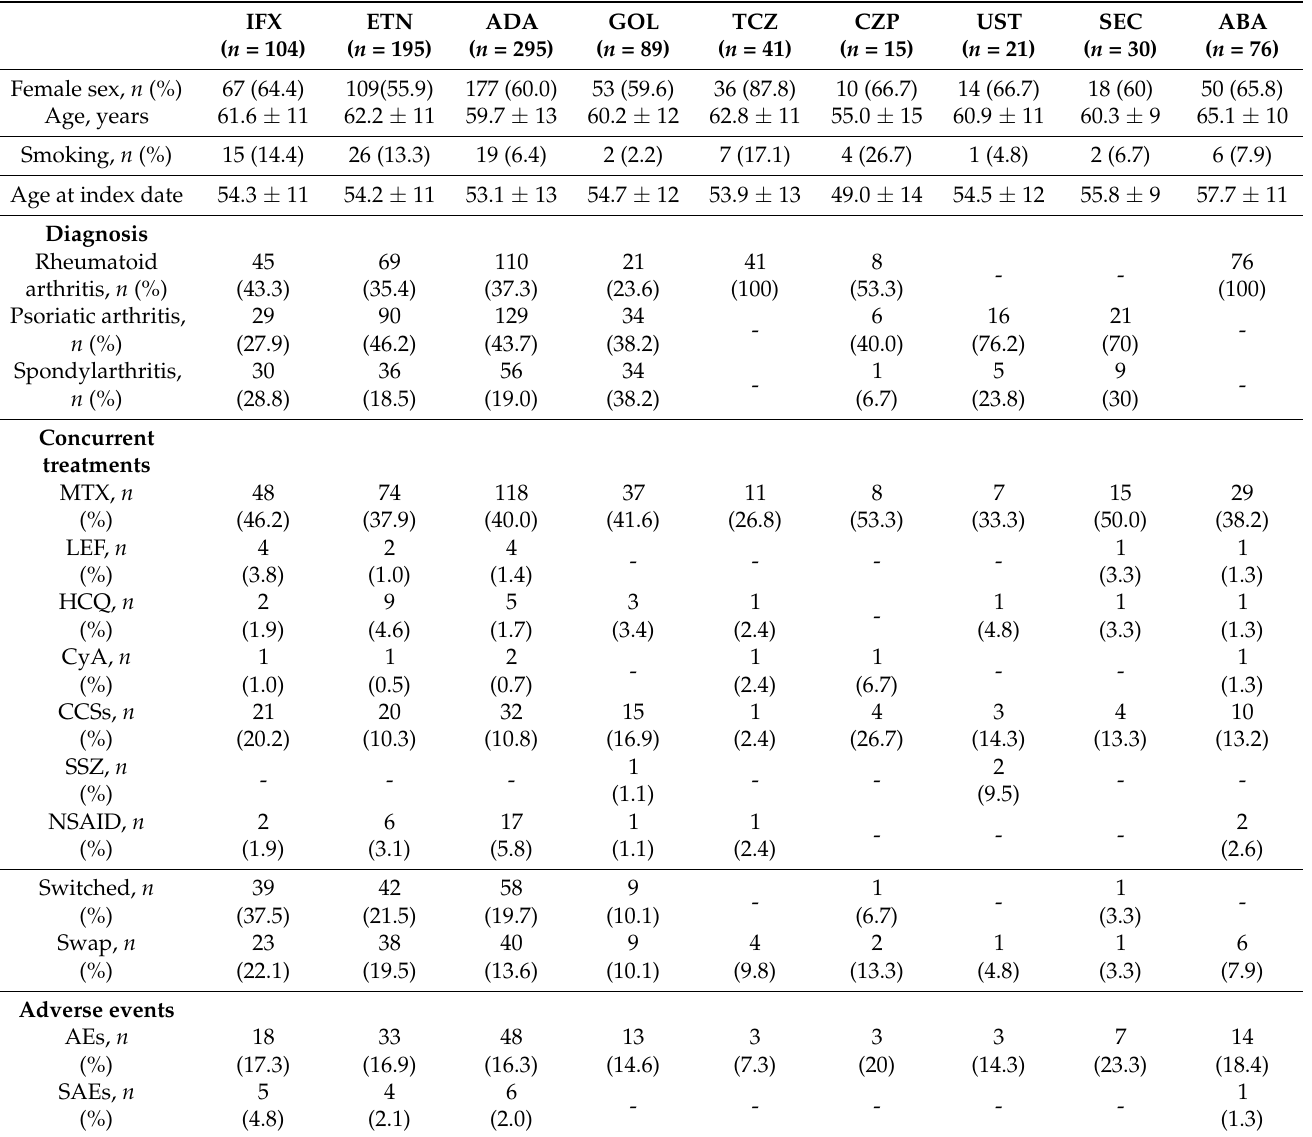
Table 2. Characteristics of the study cohort per